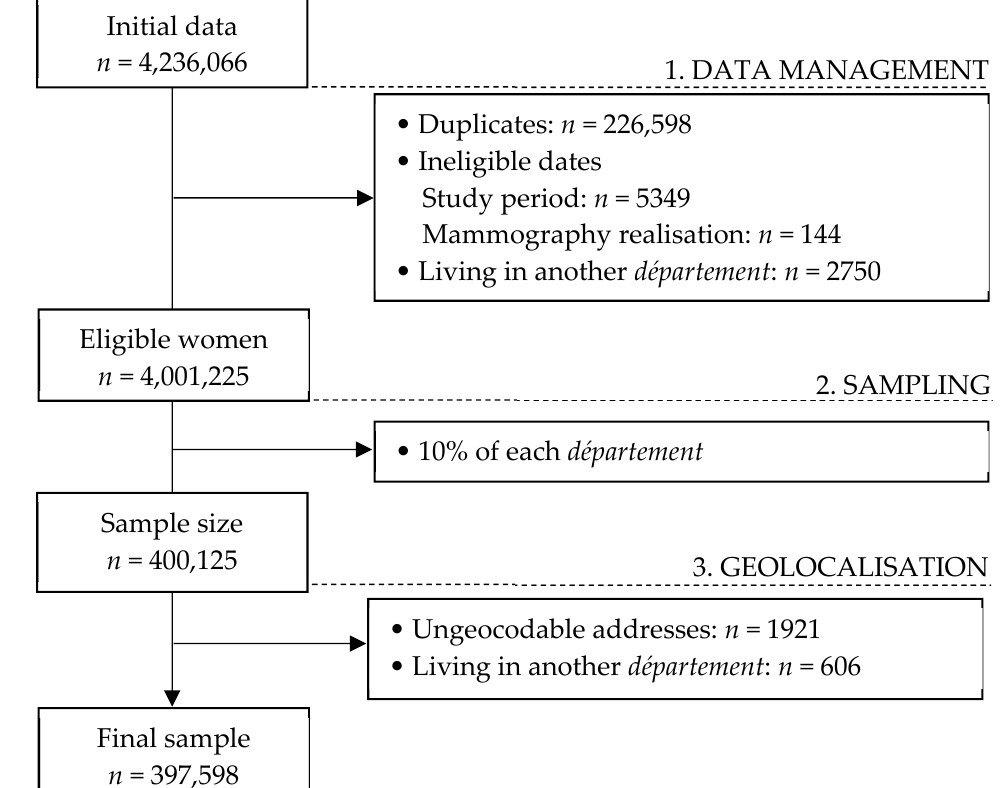
Figure 1. Flow chart of the population.